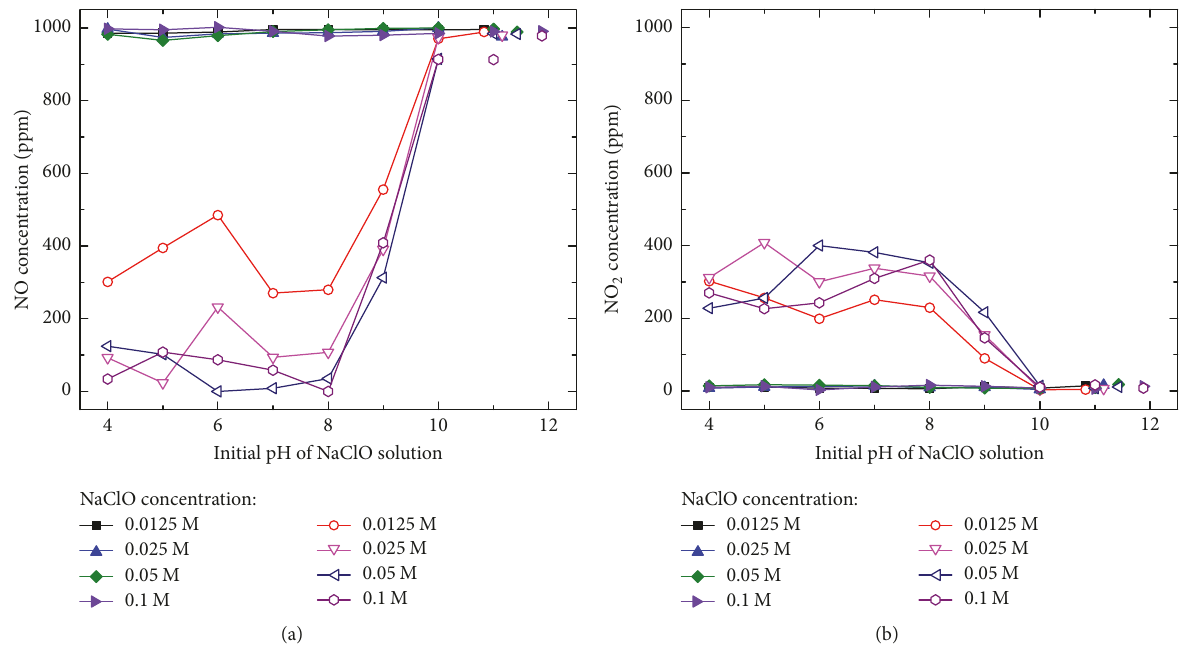
Figure 5: The change of (a) NO concentrations and (b) NO 2 concentrations in flue gas with initial pH of NaClO solution (gas flow is 1.25 L/min, inlet NO concentration is 1000 ppm, NaClO concentration is in the range of 0.0125–0.1M, and solution temperature is 293 K; x solid points refer to inlet NO concentrations and open points refer to outlet NO x